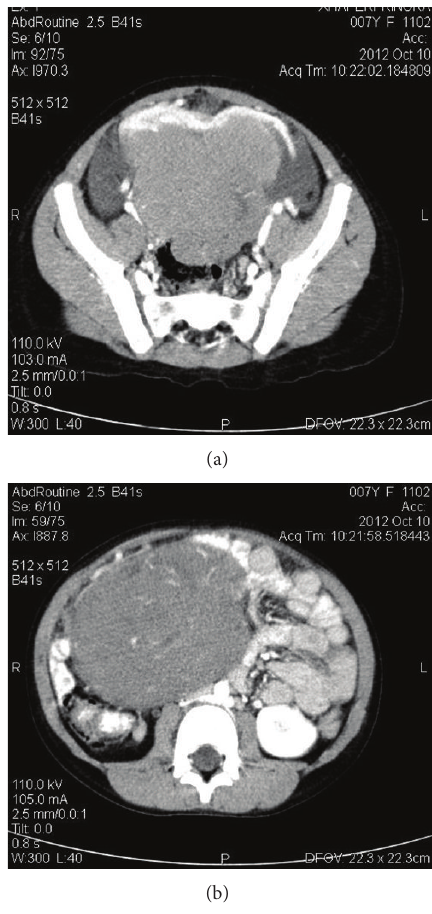
Figure 1: CT scan of the abdomen and pelvis revealed a massive, solid, and clearly bordered formation with the dimensions 12 × 8 × 15 cm. The suspicious formation showed a connection to the right ovary that was hyperdense and had an inhomogeneous appearance. Some hypodense tissue within the tumour mass was identified as probably “fatty tissue.”